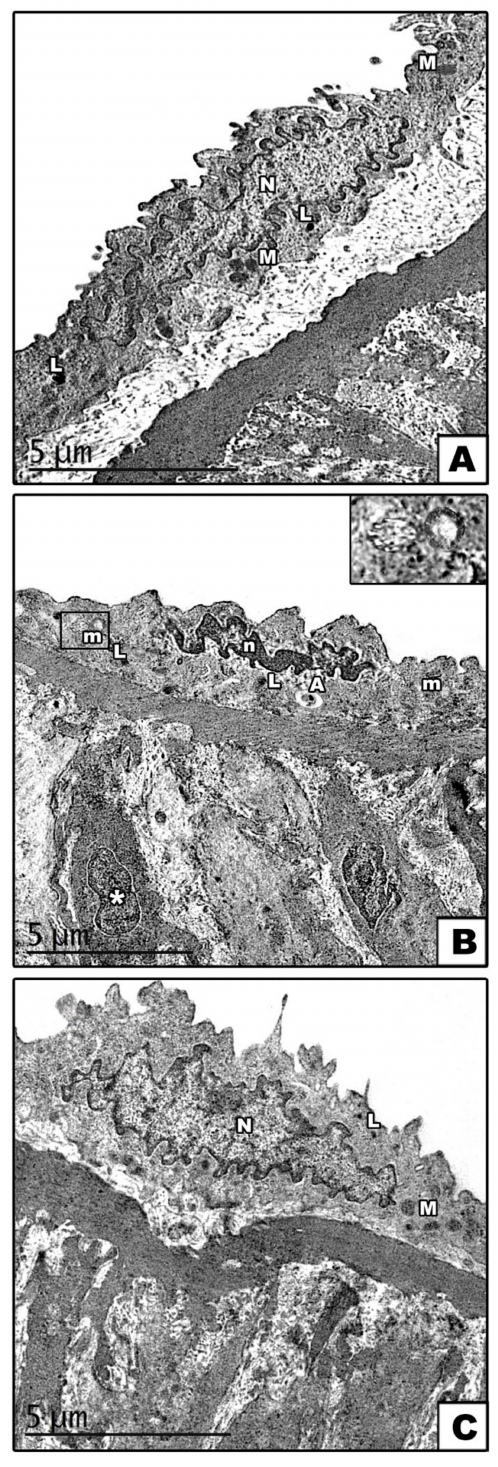
Figure 4. Electron micrographs of sections in the carotid arteries ( A ): In the control groups, the en- dothelial cells have a euchromatic nucleus (N), and its cytoplasm contains mitochondria (M) and few lysosomes (L). ( B ): In the reserpine-treated group, small heterochromatic nuclei (n) in the endothelial cells, mitochondria (m) with destructed cristae, numerous lysosomes (L), and autophagosome (A) are observed in the cytoplasm. Note the presence of apoptotic smooth muscle cells (asterisks) with a heterochromatic nucleus and condensed cytoplasm in the tunica media. The boxes indicate the destructed cristae of the mitochondria. ( C ): In the fisetin-treated group, normal endothelial cells with a euchromatic nucleus (N), normal mitochondria (M), and few lysosomes (L) are